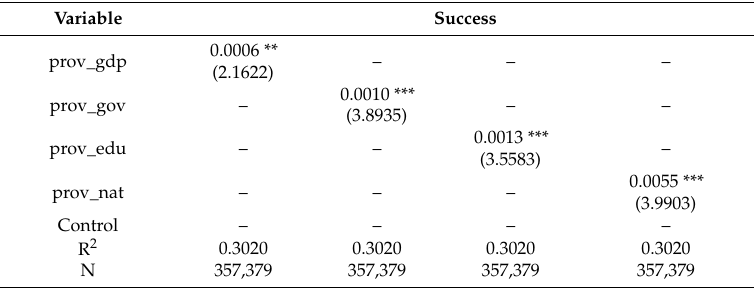
Table 8. Robustness test results of loan success rate (change sample).